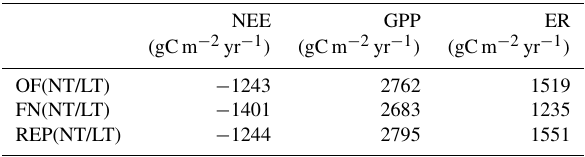
Table 1. Annual sums of NEE, GPP and ER for 2013 at AU-Tum processed with the u ∗ threshold value set to 0.24ms − 1 .